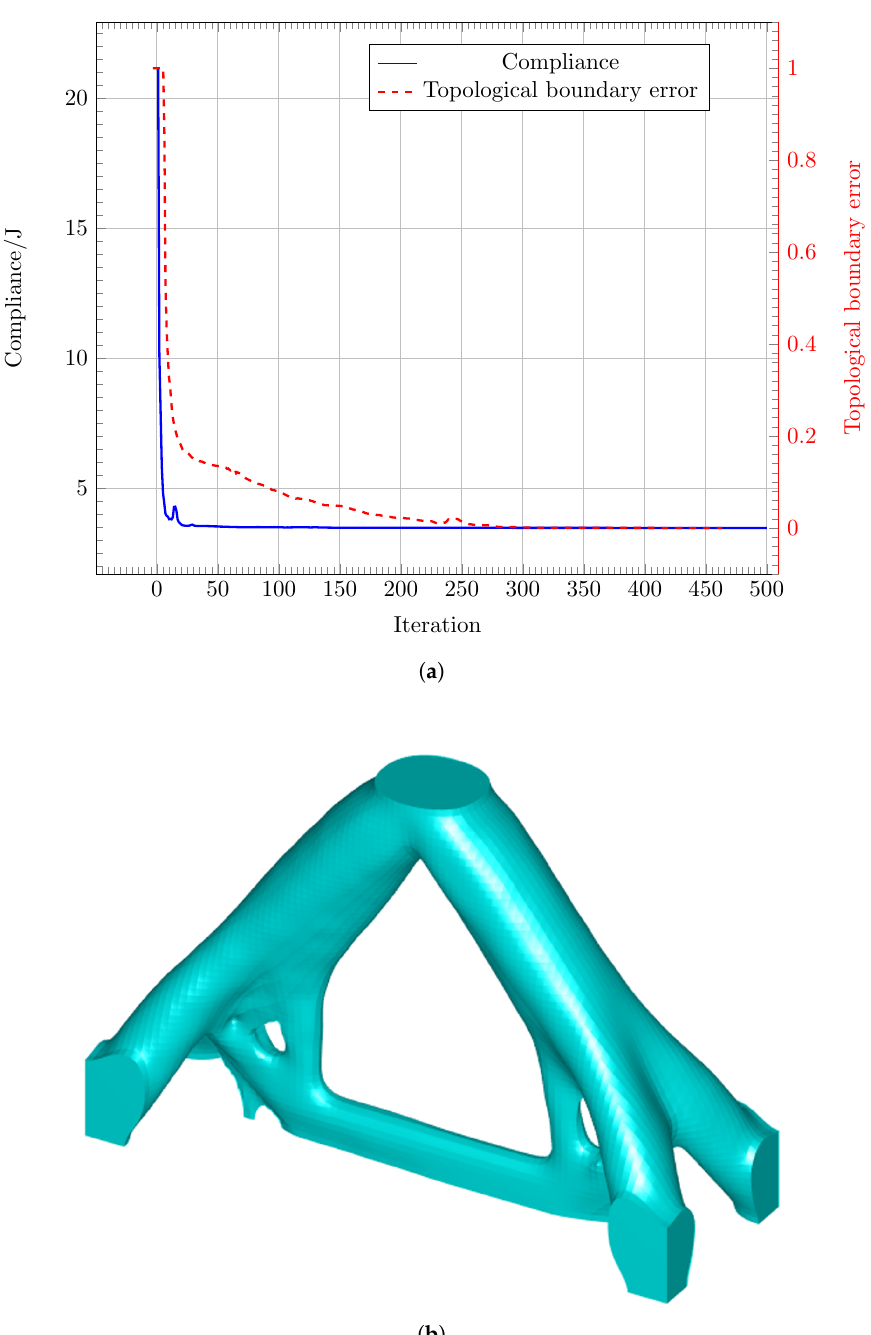
Figure 7. Convergence process and optimized topology with a fine mesh for a target volume fraction of 0.15: ( a ) convergence process, ( b ) Optimized